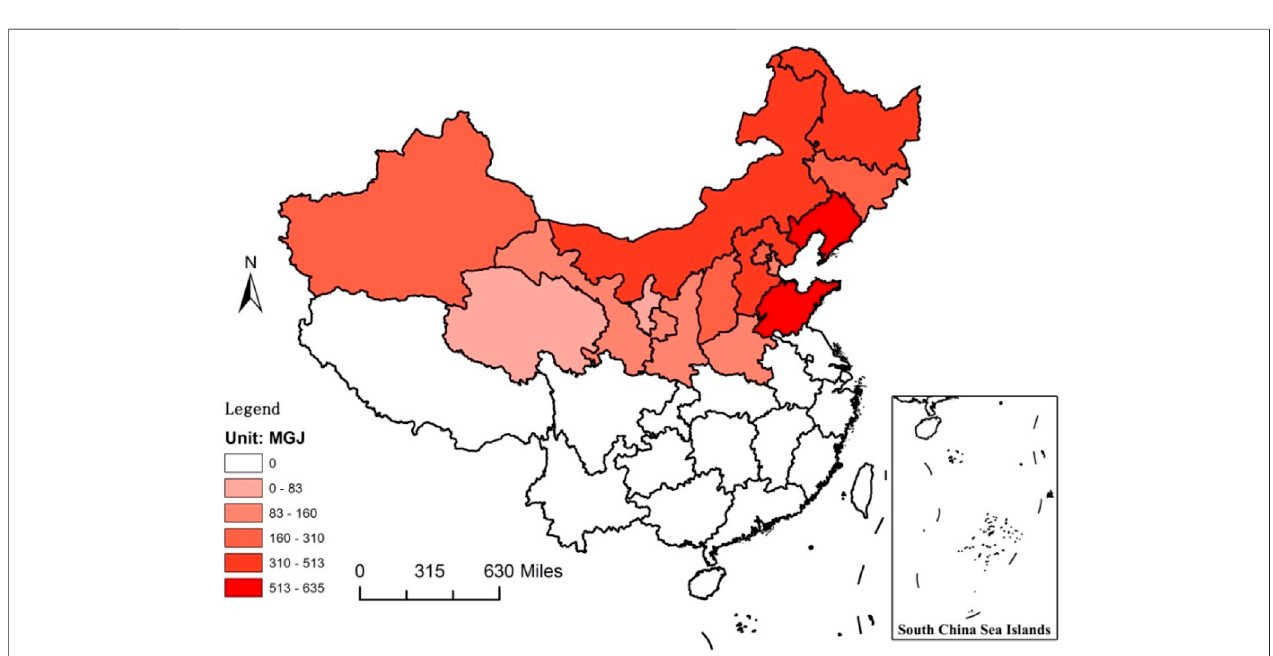
FIGURE 2 | Distribution of central heating in various provinces in China in